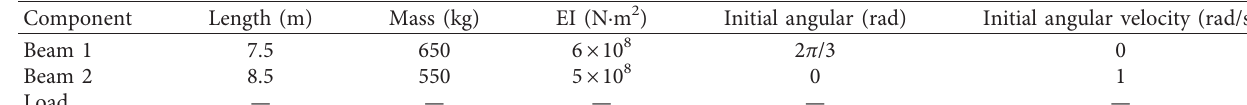
Table 1: Design parameters and initial values.